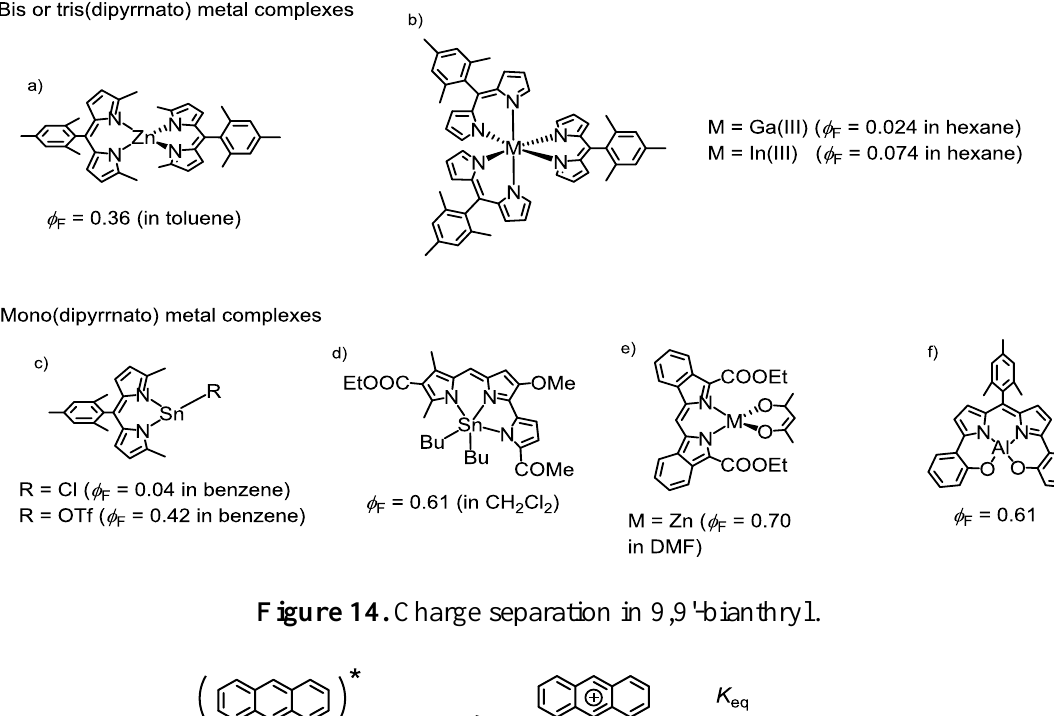
Figure 13. Fluorescent mono, bis, and tris(dipyrrinato) metal complexes.